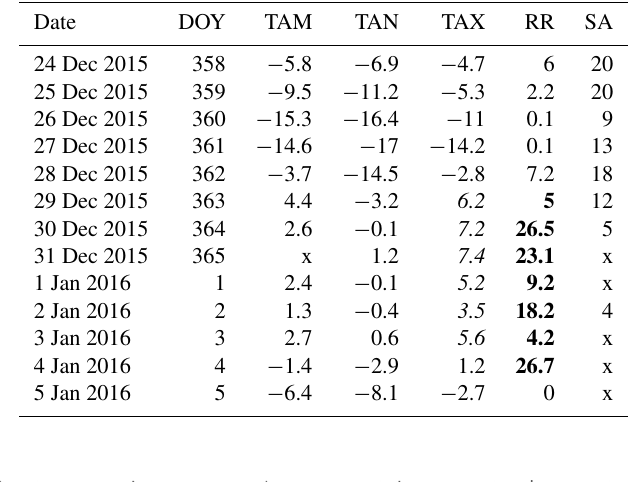
Table A1. Measured temperature (TAM is mean, TAN is minimum, TAX is maximum), precipitation (RR; mm) and snow depth (SA; cm) from the Ny-Ålesund meteorological station, in the period between two acquisitions of Sentinel-1A data (24 December 2015 to 5 Jan- uary 2016). Precipitation and maximum temperature marked in bold and italic might have contributed to wet and warm conditions on the glaciers. (x indicates no data.)